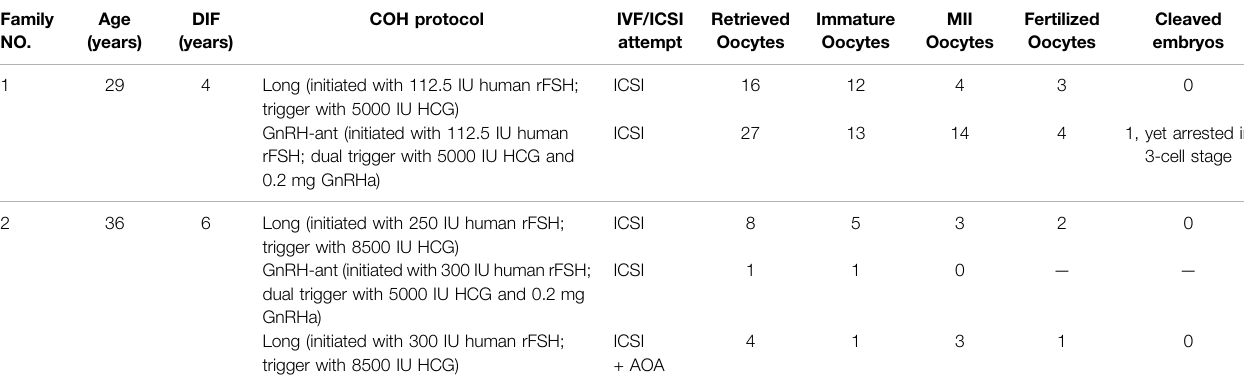
TABLE 1 | Oocyte and embryo characteristics of ICSI attempts for the affected individuals. Family